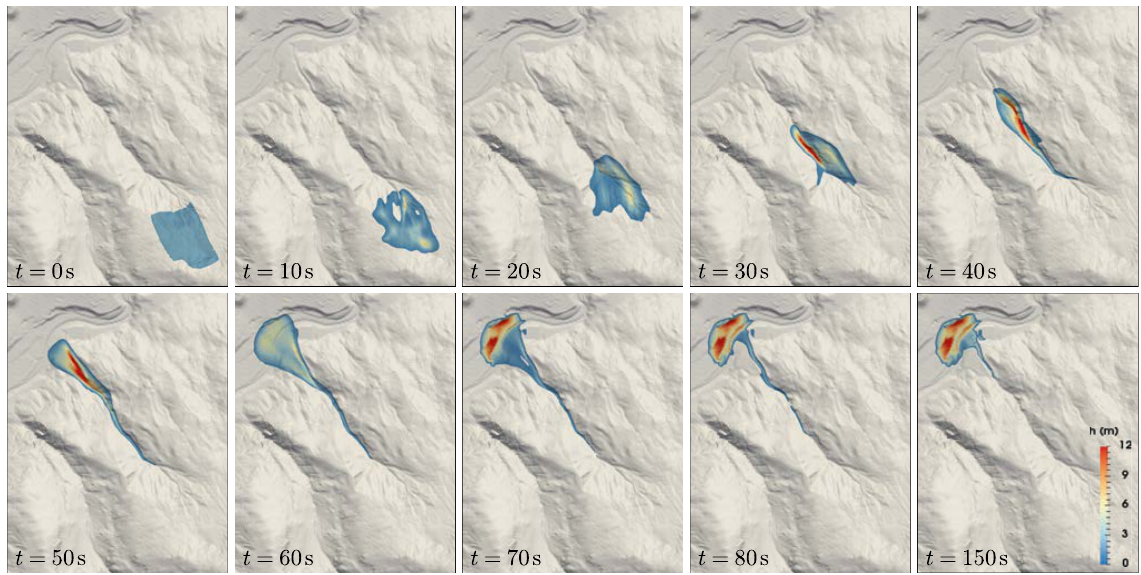
Figure 4. Time series of an OpenFOAM simulation with mean cell size (cid:49) = 7 . 45m and first-order interpolations in ParaView. The colour scale represents flow thickness, which is clipped at 0 . 5m. Terrain data: AdTLR.